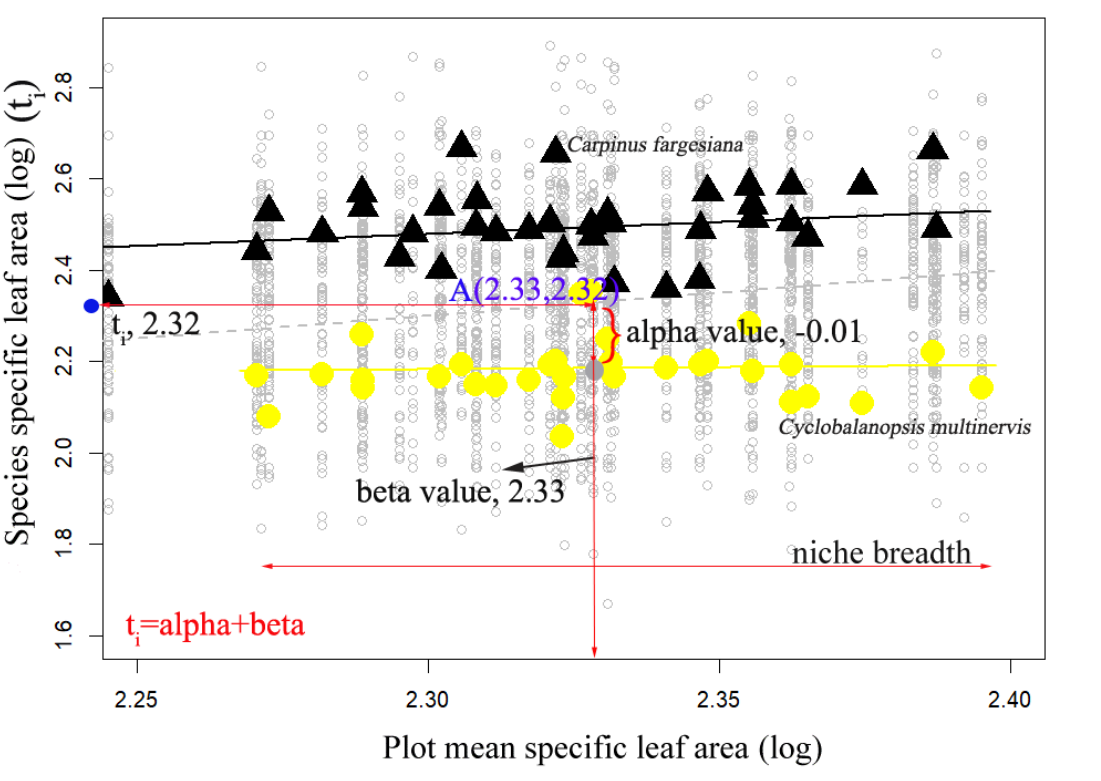
Figure 1. Scatterplot of species trait values vs. abundance-weighted plot mean trait values for log10 specific leaf area (cm 2 / g) in a subtropical evergreen deciduous broadleaved mixed forest. Dashed line is X = Y . Values for two species are highlighted for illustration: Cyclobalanopsis multinervis (circles, evergreen species), Carpinus fargesiana (triangles, deciduous species). For each species, the large point shows the mean position of occupied plots (beta value, on abscissa) and mean species trait value (t i , on ordinate). The di ff erence between these, or the distance from the X = Y line, is alpha value. The range of occupied plots on the x-axis is the species niche breadth. Regression line shows abundance-weighted least squares regression of species trait values relative to plot mean trait values. For Cyclobalanopsis multinervis , beta value was 2.33, towards the low end of the gradient, and alpha value was − 0.01, so the mean species trait value was 2.32.